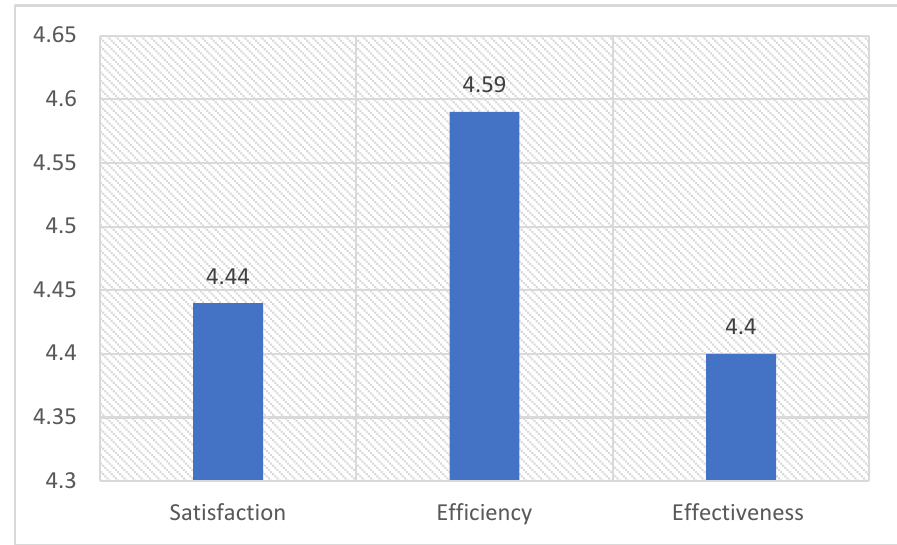
Figure 15. Mean values per parameter for measuring usability on a Likert scale.